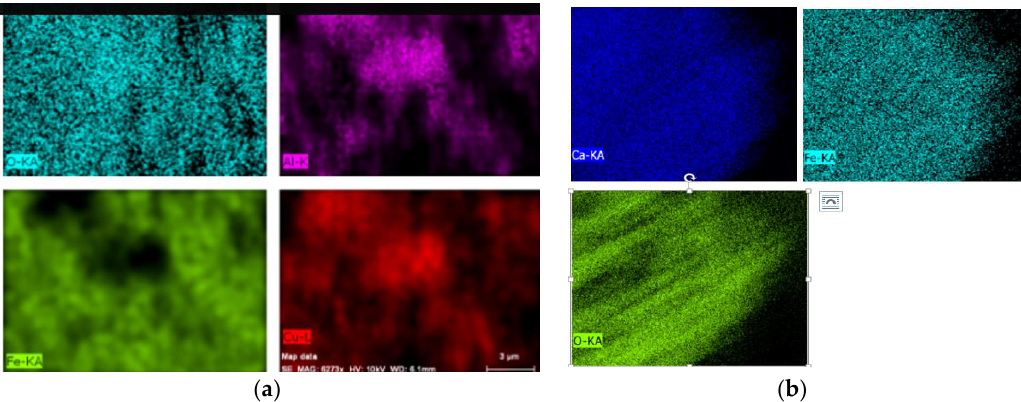
Figure 2. Elemental mapping of fresh oxygen carriers with ( a ) Fe-Cu oxide on an Al 2 O 3 support, and ( b ) Fe-Ca